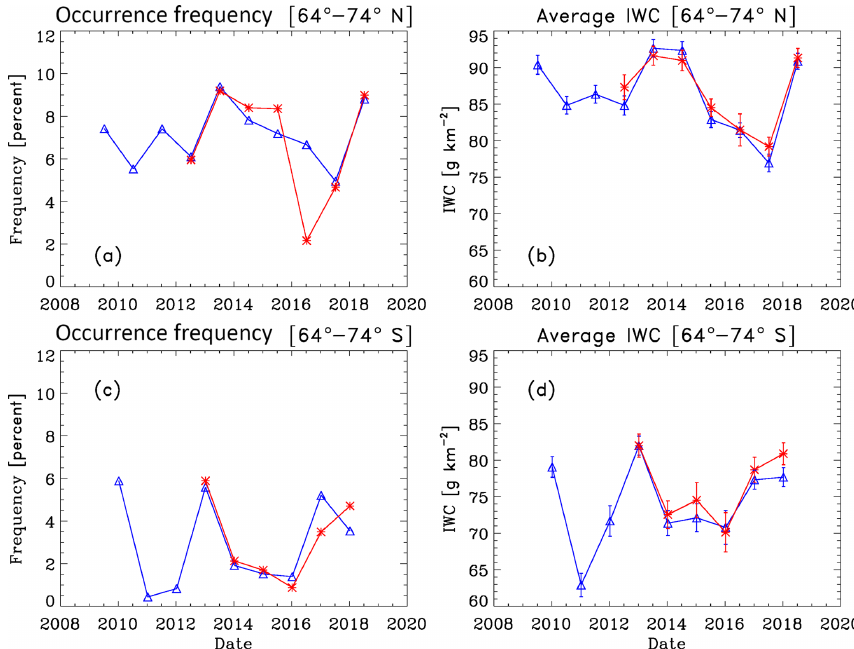
Figure 5. Season average occurrence frequency and IWC data at 64–74 ◦ latitude. Identifications are as in Fig.